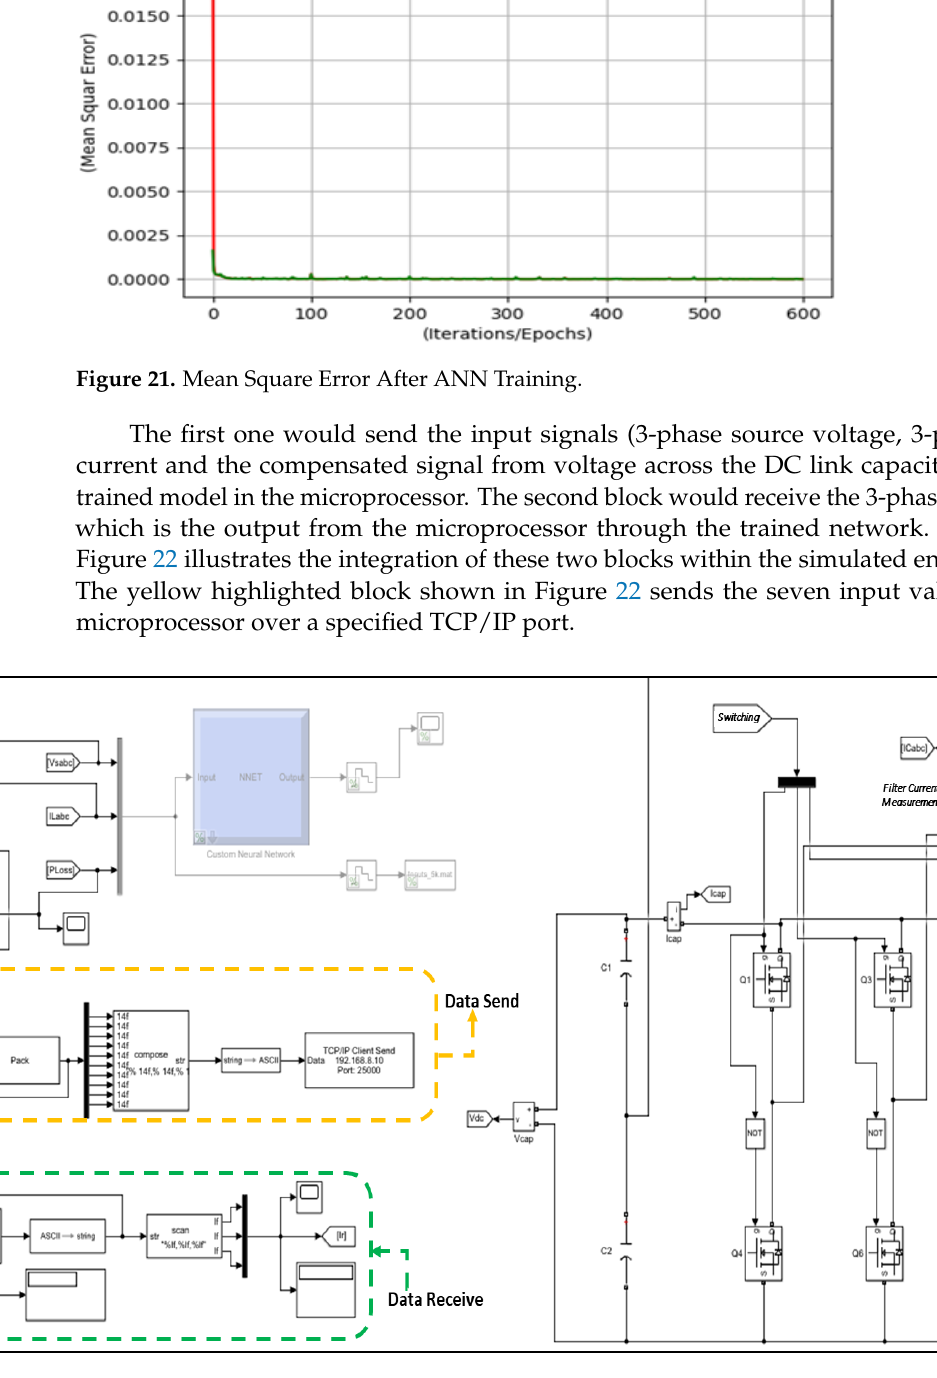
Figure 22. Data transmitting and Receiving in between SIMULINK and Raspberry PI.